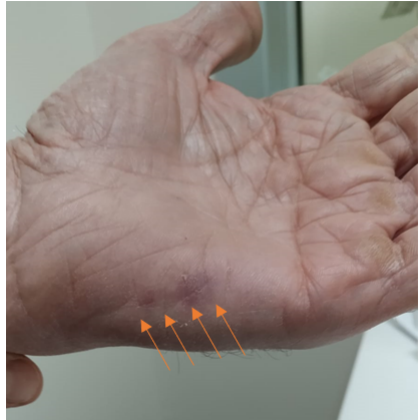
Figure 1. Redness swelling in hypothenar eminence of left hand (the arrows indicate the lesion). The patient, a radiology Technician, showed the hand to the Radiologist that worked with him in the Radiology Unit and a musculoskeletal ultrasound was performed, using greyscale and Doppler imaging. Consequently, a thrombosis of the arcuate branch of the ulnar artery measuring 30 mm was identified (Figure 2).